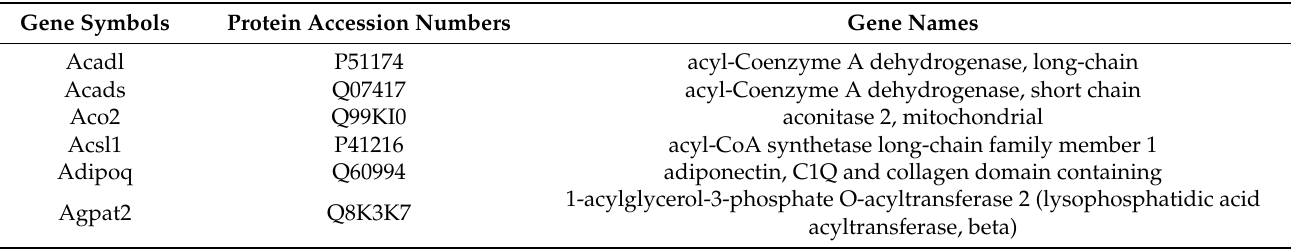
Figure 4. Significant enrichment analyses were performed on the 65 proteins commonly found in AdEVs released from obese mice adipose tissue based on proteomic data from [35,52,53] vs. the rest of the genome (PANTHER version 11). Only significant functions in each pathway are shown. The list of 65 proteins is available in Table 1. Table 1. Common proteins from obese adipocyte-derived extracellular vesicles (see Figure 4). Data sets are from [35,52,53]. Gene